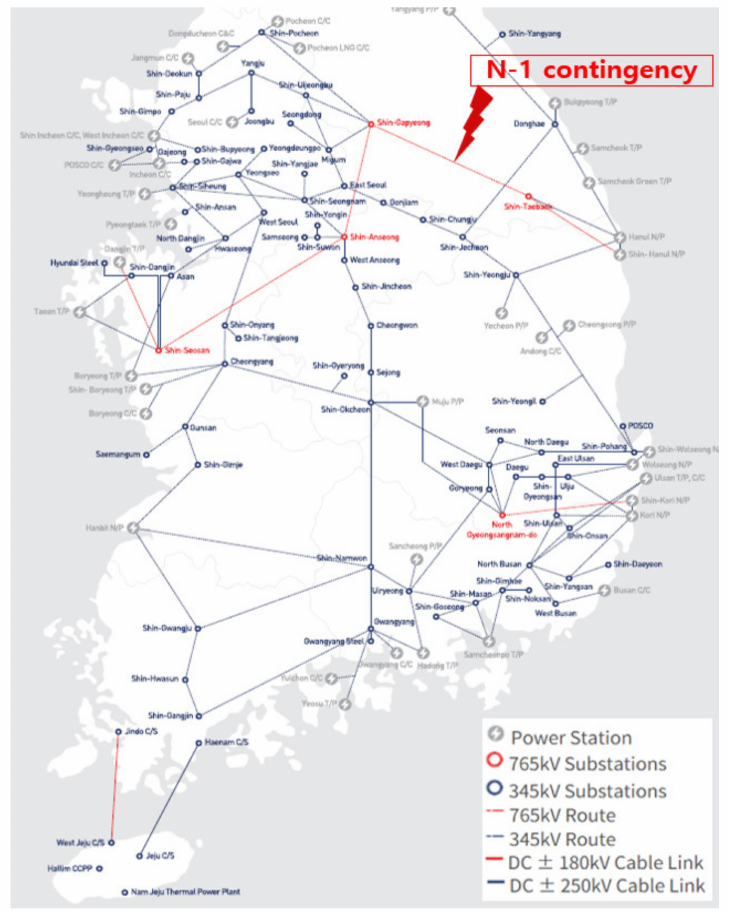
Figure 4. Structure of Korea’s power system.